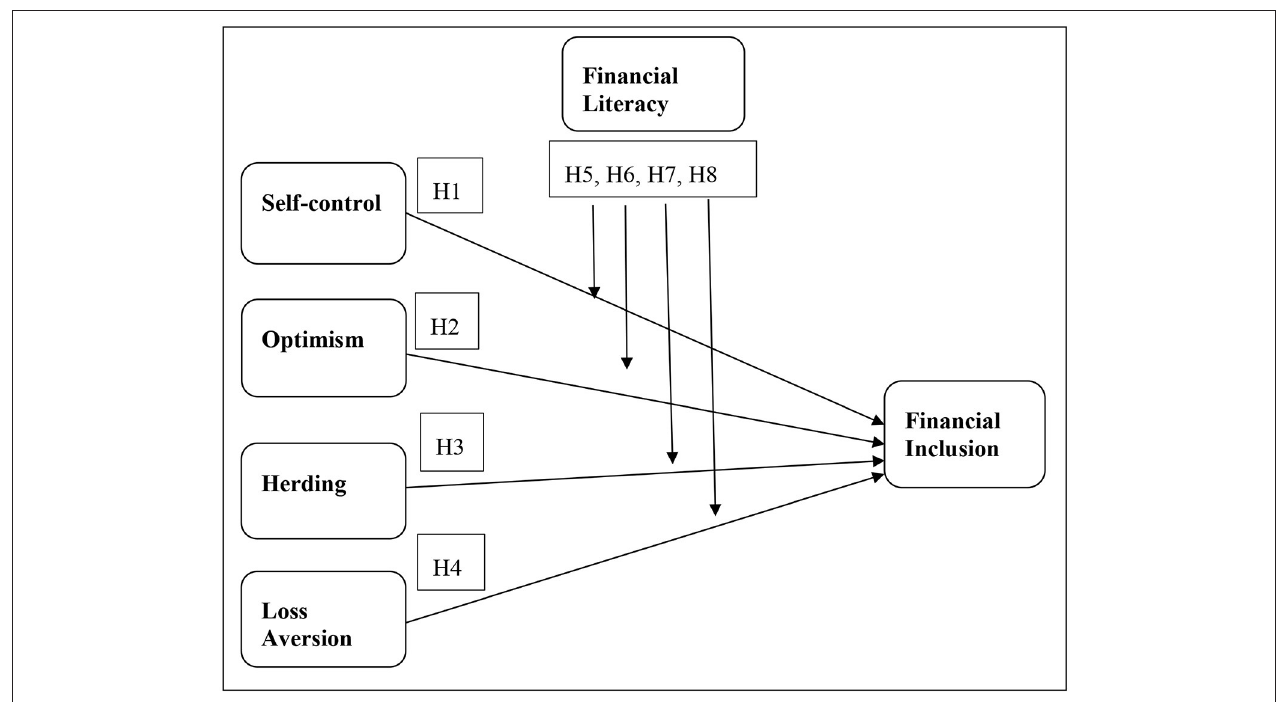
FIGURE 1 | Theoretical